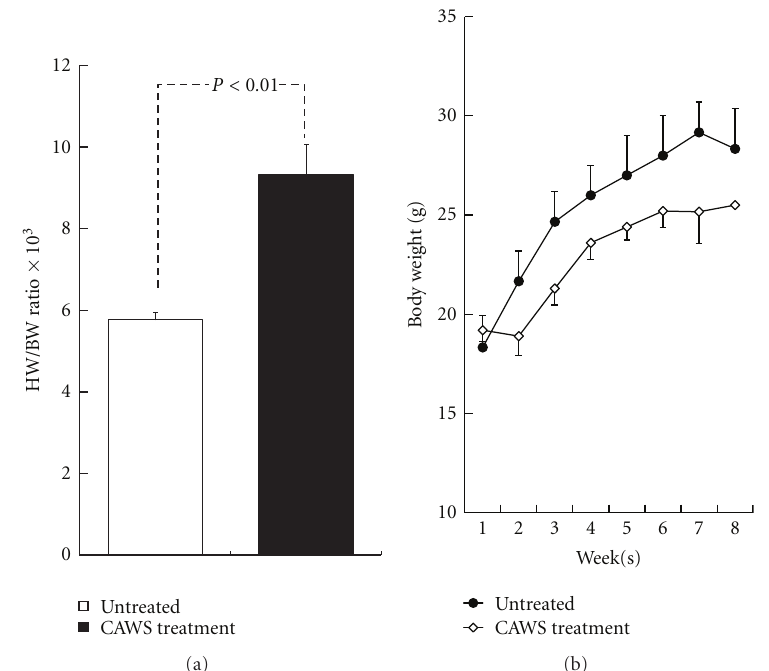
Figure 5: Heart weight and time course of body weight in CAWS arteritis. (a) The column graph represents the heart weight (HW)/body weight (BW) ratio, which increased significantly by 1.62-fold ( P < 0 . 01); n = 8 (untreated) and n = 7 (CAWS treatment). (b) The time course of body weight with/without CAWS treatment DBA/2